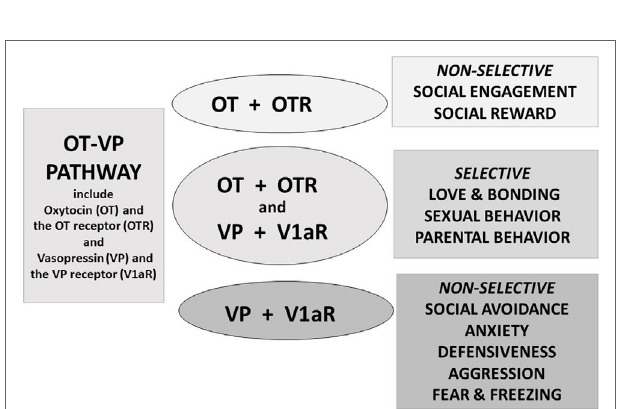
FiGURe 2 | Oxytocin (OT) and vasopressin (VP) are components of an integrated pathway. OT and VP interact dynamically with receptors [including the OT receptor (OTR) or V1a receptor (V1aR)] to influence social engagement and defensive behaviors. In many cases, OT acts in conjunction with VP, via the V1aR or through effects on both the OTR and V1aR, thus regulating the capacity to form selective social behaviors. OT rarely acts alone but, especially under nonthreatening or “safe” conditions, may facilitate features of “love,” including social engagement, and social reward, and “immobility without fear” (36).